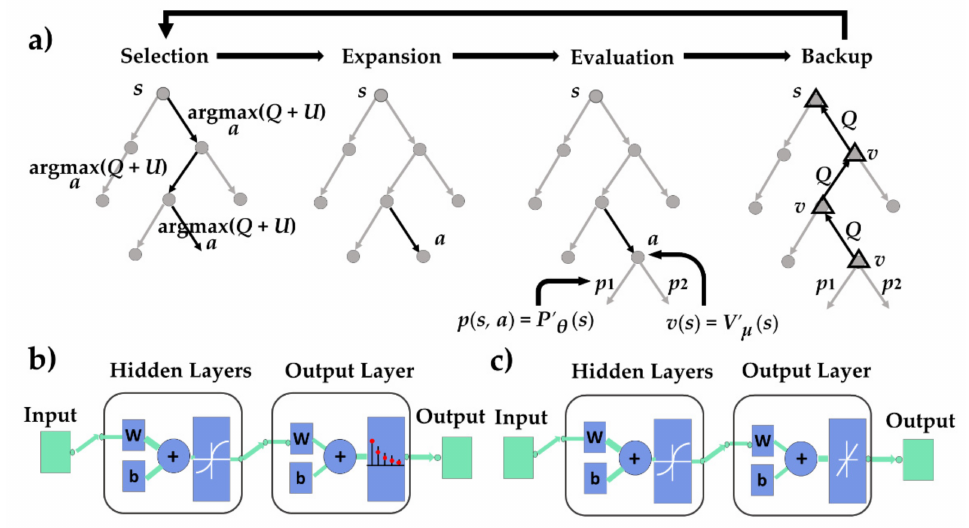
Figure 3. The truncated MCTS guided by the policy and value networks: ( a ) Truncated MCTS; ( b ) structure of the policy network P ’ θ ( s ); and ( c ) structure of the value network V ’ µ ’ ( s ). •